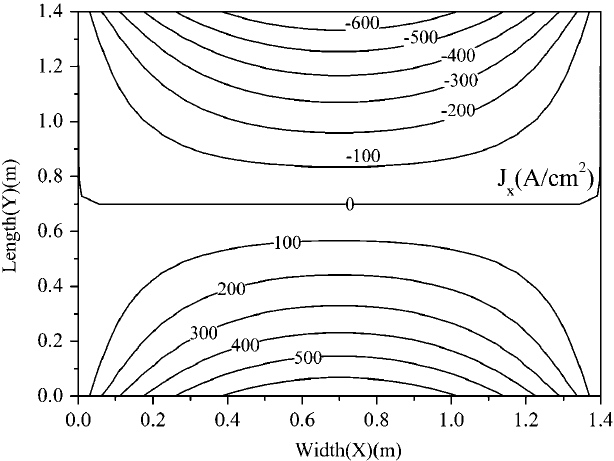
, with time for y